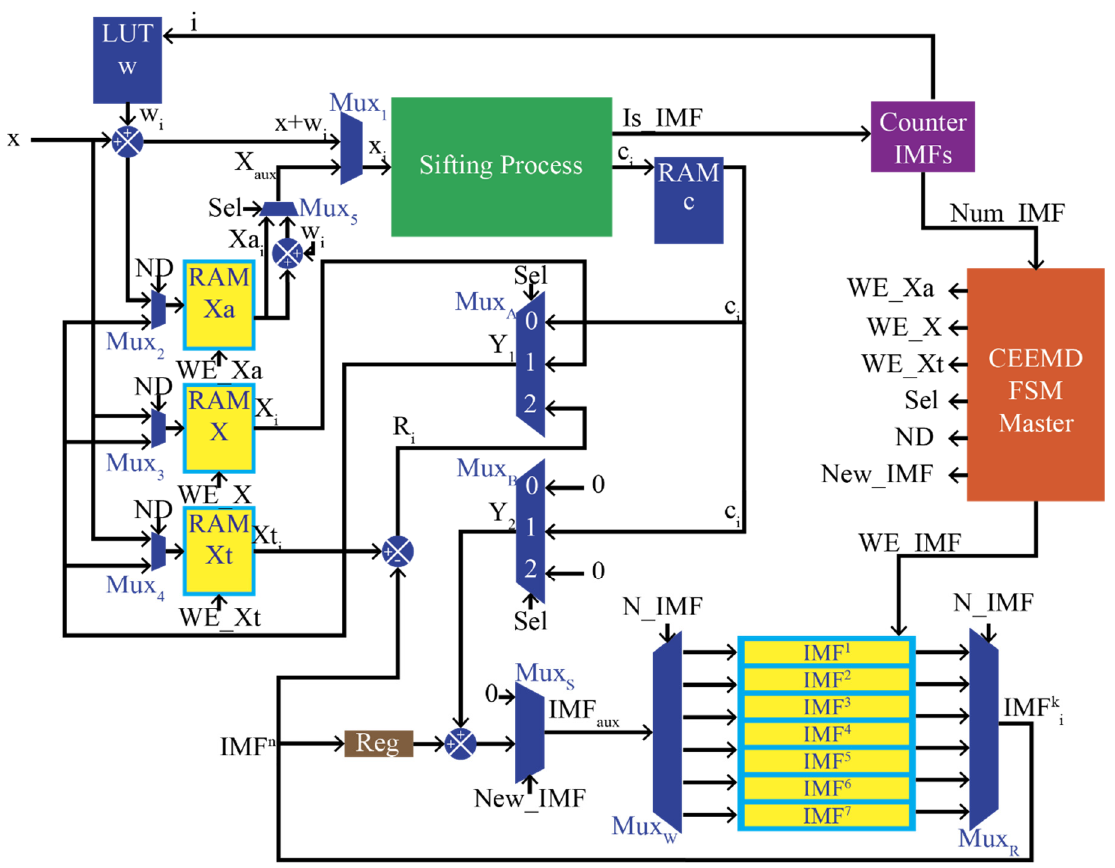
Figure 6. CEEMD module.